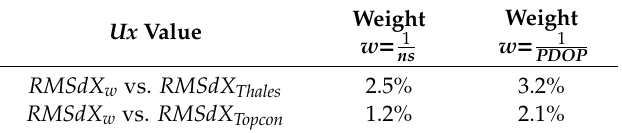
Table 2. The relation between RMS error for the tested methodology along the